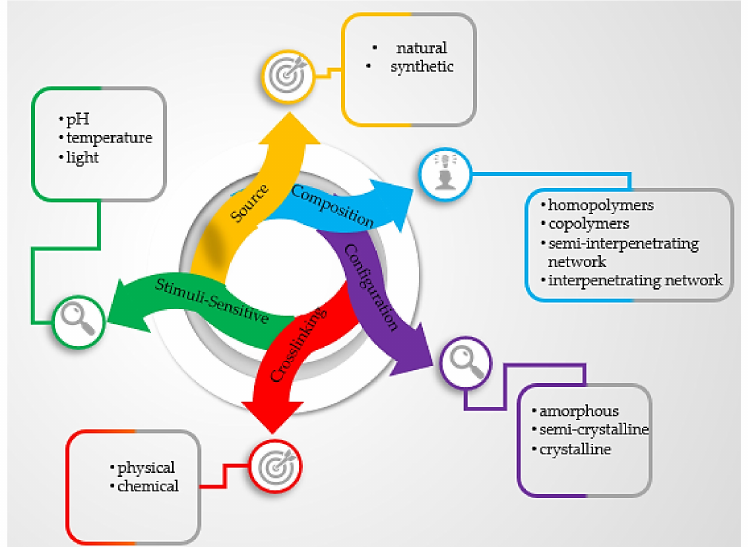
Figure 1. The main classes of